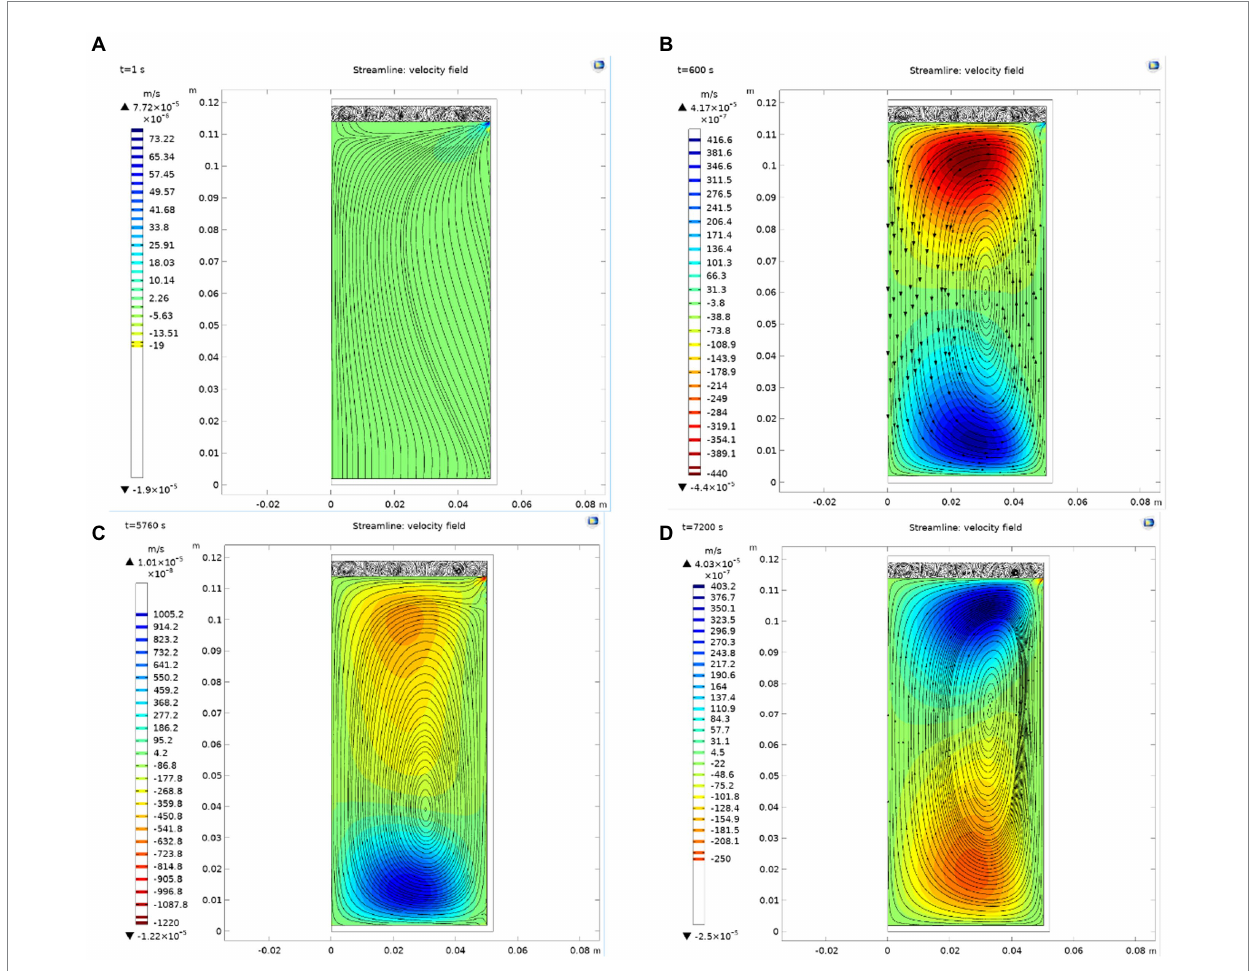
FIGURE. 3 Variation in the velocity field in the can. (A) Flow distribution in can when t = 1 s; (B) Flow distribution in can when t = 600 s; (C) Flow distribution in can when t = 5,760 s; (D) Flow distribution in can when t = 7,200